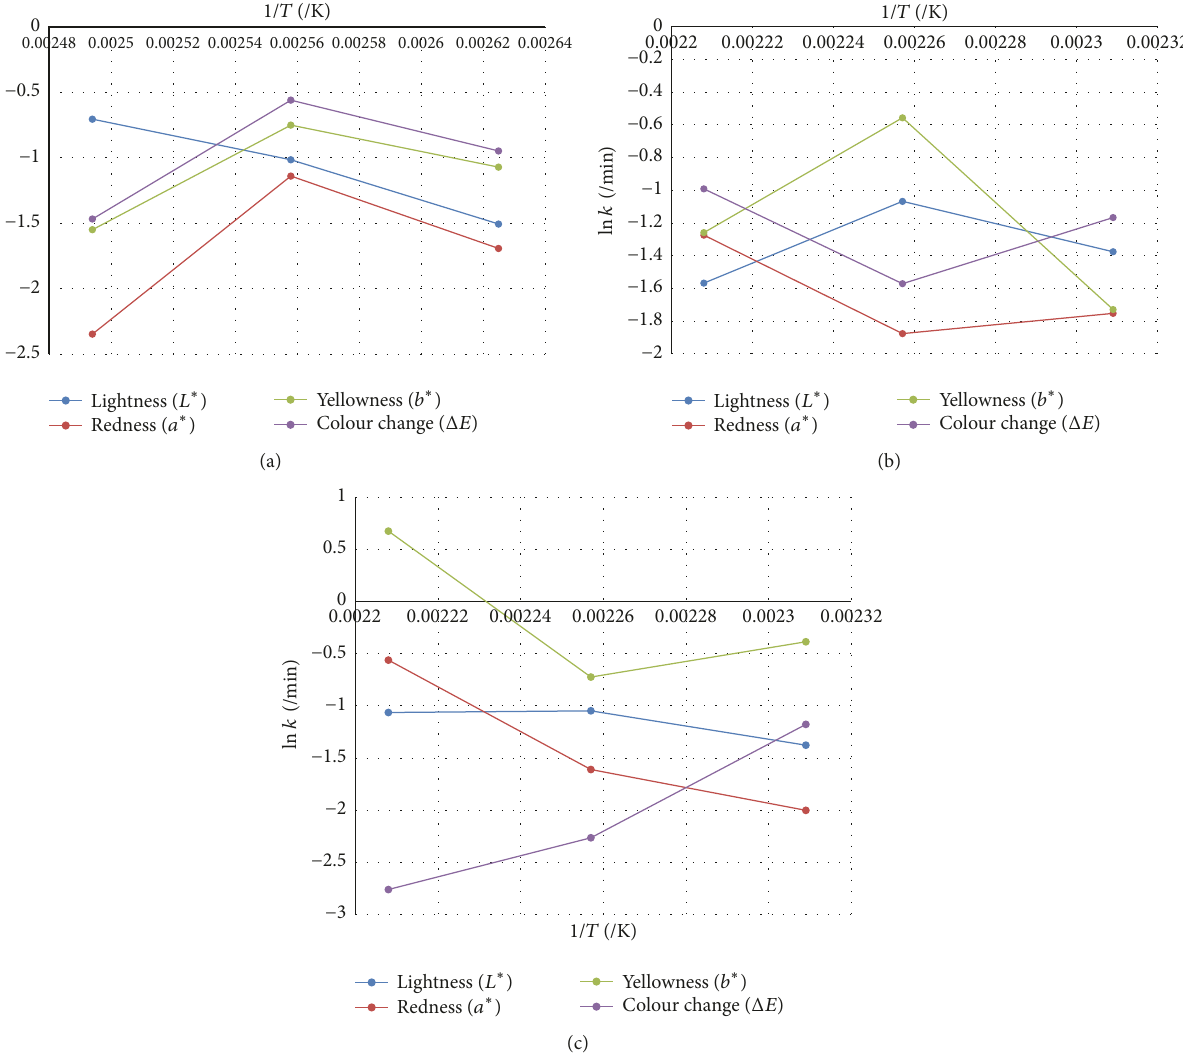
Figure 7: (a) Arrhenius plot of rate constant against frying temperatures at vacuum frying conditions for colour parameters. (b) Arrhenius plot of rate constants against frying temperatures at atmospheric frying conditions colour parameters (fresh slices). (c) Arrhenius plots of rate constants against frying temperature at atmospheric frying conditions for colour parameters (predried